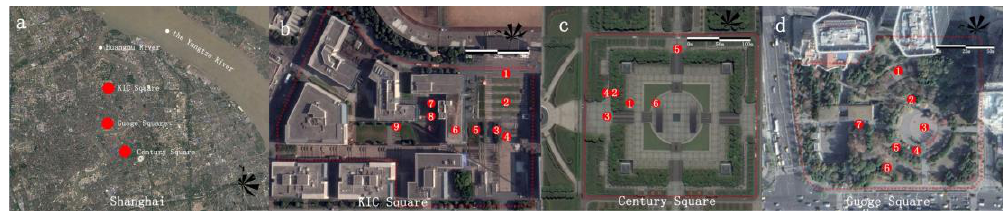
Figure 1. Experiment sites and spots. ( a ) Shanghai and locations of the three squares: ( b ) KIC square, ( c ) Century square, and ( d ) Guoge square. Numbers in the sub-figures indicates the experiment spots.